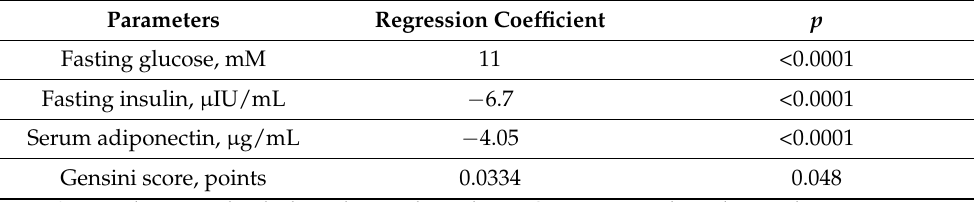
Table 5. Logistic regression